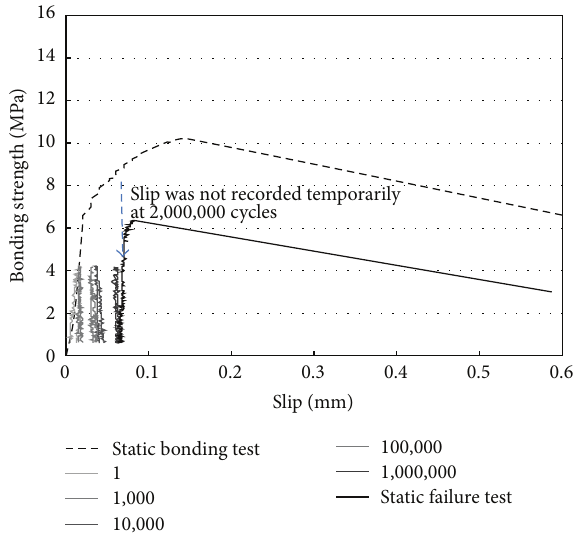
Figure 10: Bond stress-slip relationship of the 10𝑑 𝑏 specimen under 70% stress level of the ultimate